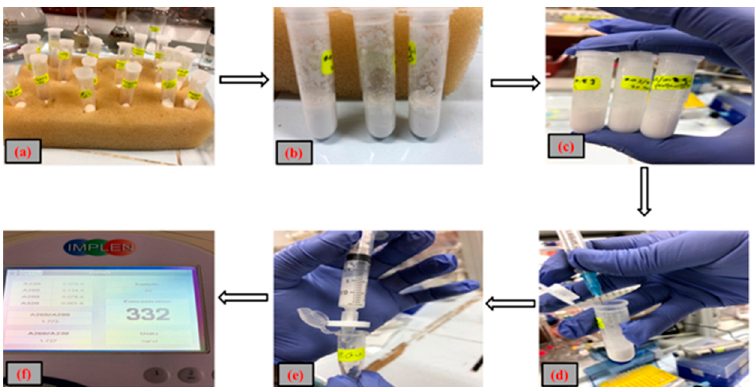
Figure 1. Schematic representation of the process to extract DNA using our polymer/Si NC. As shown in the figure, the following steps were carried out: ( a ) poly(4,4’-cyclohexylidene bisphenol oxalate)/Si(13 wt.%) NCs, weighing in the order of 0.2 g, 0.01g, and 0.02 g, were inserted into Eppendorf tube; ( b ) we added binding buffer and DNA solution to a total volume of 500 μ L; ( c ) incubation for 10 min; ( d ) we took out the solution; ( e ) separation of elution from the polymer NC; and ( f ) the efficiency and purity of the extracted DNA was assessed from the eluted buffer by NanoPhotometer™.